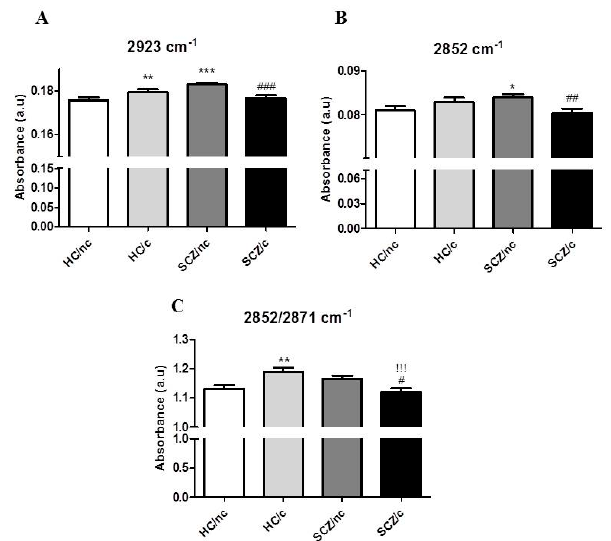
Figure 2. Major peak amplitudes related to the CH2 ( A ) 2923 cm-1, ( B ) 2852 cm-1 and ( C ) the ratio between 2852/2871 cm-1 in ON cells from healthy controls non-cannabis users (HC/nc); healthy controls cannabis users (HC/c); schizophrenic patients non-cannabis users (SCZ/nc) and schizophrenic patients cannabis users (SCZ/c). The data are expressed as means ± S.E.M. * p < 0.05; ** p < 0.01; *** p < 0.001 vs. HC/nc. ! p < 0.05; !! p < 0.01; !!! p < 0.001 HC/c vs SCZ/nc. # p < 0.05; ## p < 0.01; ### p < 0.001 SCZ/nc vs SCZ/c.